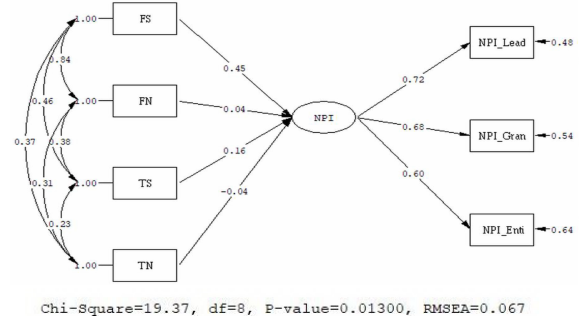
Figure 2. MIMIC model of Narcissistic Personality Inventory–13 (NPI-13).